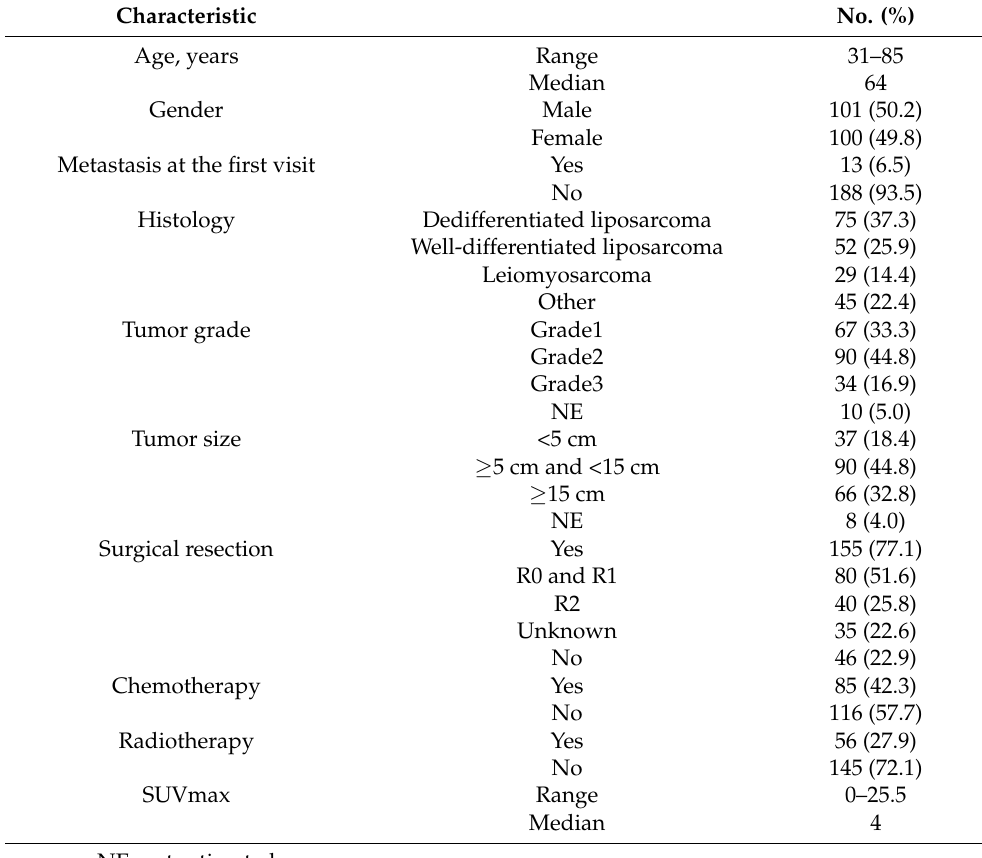
Table 1. Clinicopathologic and treatment